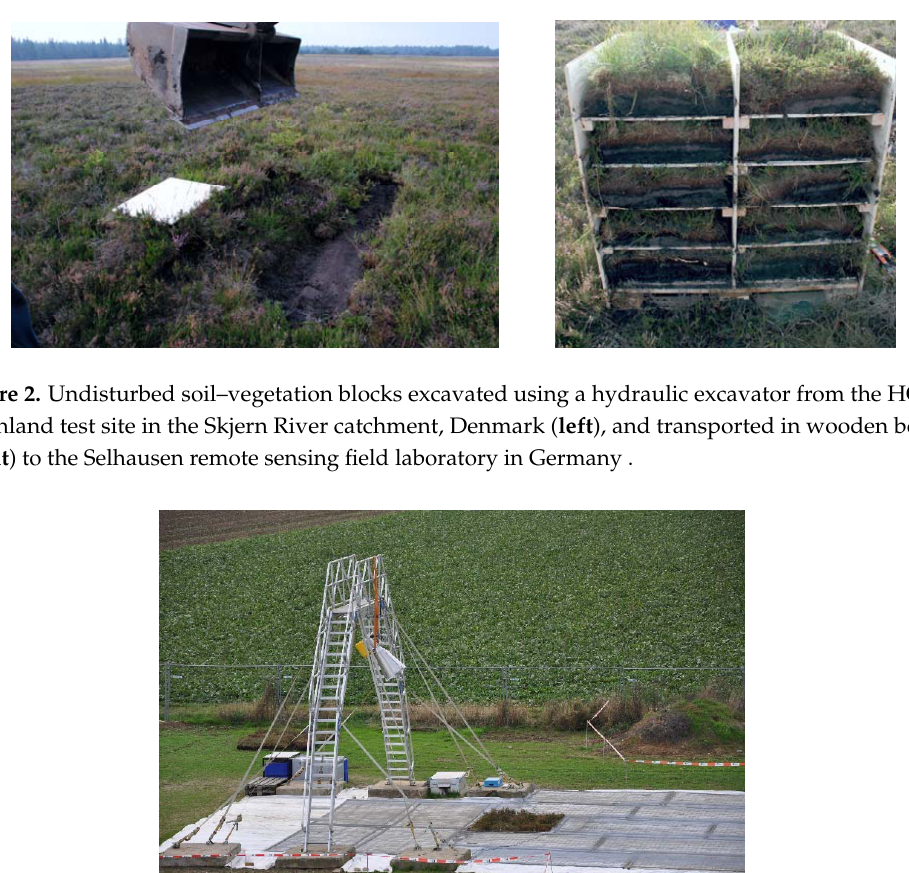
Figure 3. The Selhausen remote sensing field laboratory (Germany) consisting of an L-band radiometer (yellow box + conical horn antenna) fixed at 4 m height on an aluminium arc and a sand box covered by the soil–vegetation blocks in the centre of a wire grid.